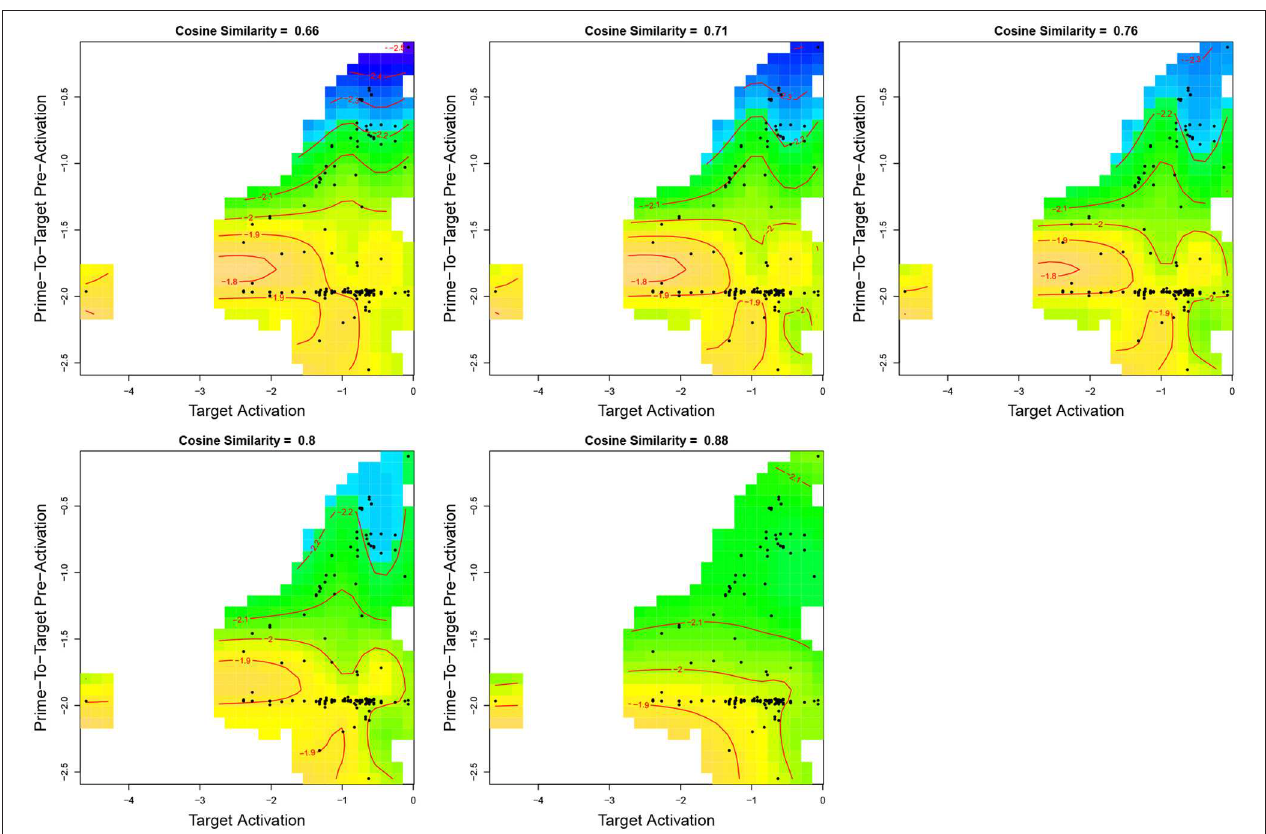
FIGURE 5 | Interaction of Target Activation by Prime-to-Target Pre-Activation by Prime-to-Target Cosine Similarity in a GAMM fitted to the inverse-transformed reaction times. Darker shades of blue indicate shorter reaction times, and darker shades of yellow longer RTs. For visualization, one extreme outlier value for Prime-to-Target Pre-Activation was removed (13 datapoints). Contour lines are 0.1 inverse RT units